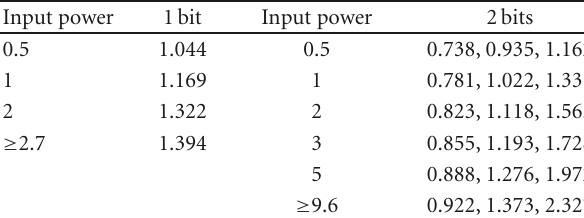
Table 1: Optimal quantization boundaries, reliable quantization region detection, long-term power constraint, and CG distribution: Nakagami, μ = 2, w = 1.